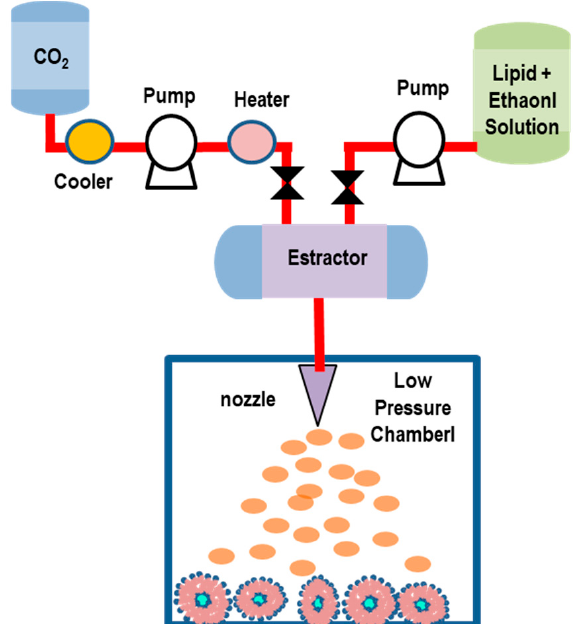
Figure 11. Schematic representation of the RESS method for liposome preparation. Initially, lipids are dissolved in supercritical CO 2 and ethanol (5–10% of v / v ) within an extractor. The resulting solution is depressurized through a heated nozzle in a low-pressure chamber. Finally, the formation of particles is generated, due to the supersaturation.